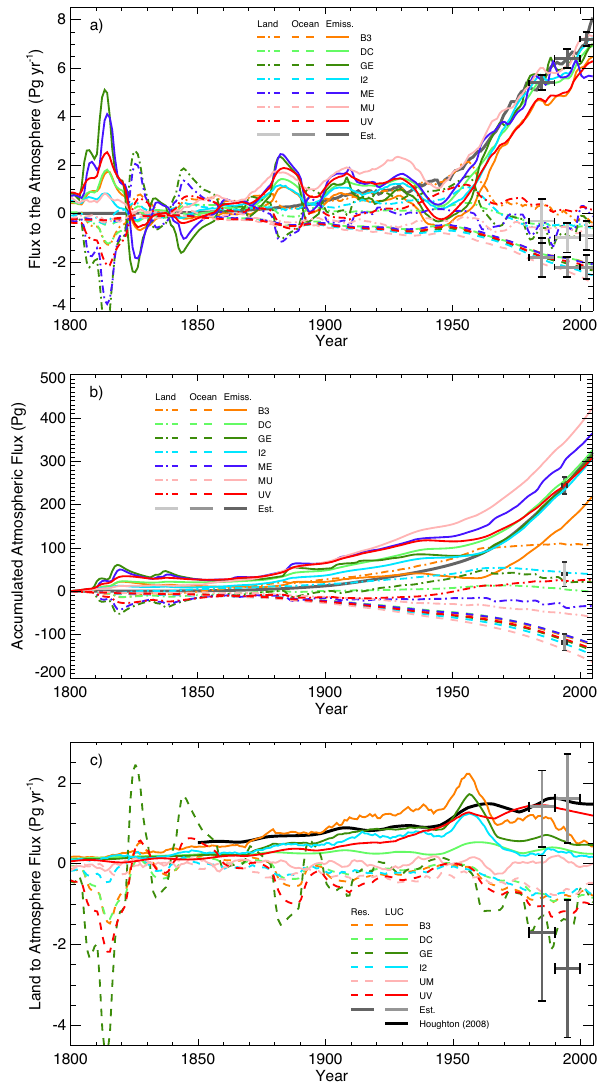
Fig. 5. Carbon fluxes to the atmosphere from the land, ocean and an- thropogenic emissions since 1800 from models with land and ocean carbon cycle components. Fluxes are shown in (a) , the accumulated flux or change in pool carbon in (b) and the components of the land flux in (c) . The land-use change (LUC) component was cal- culated from a simulation that only included land-use change forc- ing. The residual component (Res.) is calculated as the difference in land fluxes between a simulation with all forcing and one with just land-use change forcing. The model results in (a) and (c) have been processed with a 10yr moving average, rectangular filter. The data and uncertainty estimates for the years 1980–1989, 1990–1999 and 2000–2005 in (a) and (c) are from Table 1 in Denman et al. (2007). The data and uncertainty estimates at year 1994 in (b) are from Sabine et al. (2004). The solid black line in (b) indicates fossil fuel emission estimates from Boden et al. (2012) and in (c) the LUC flux estimates from Houghton